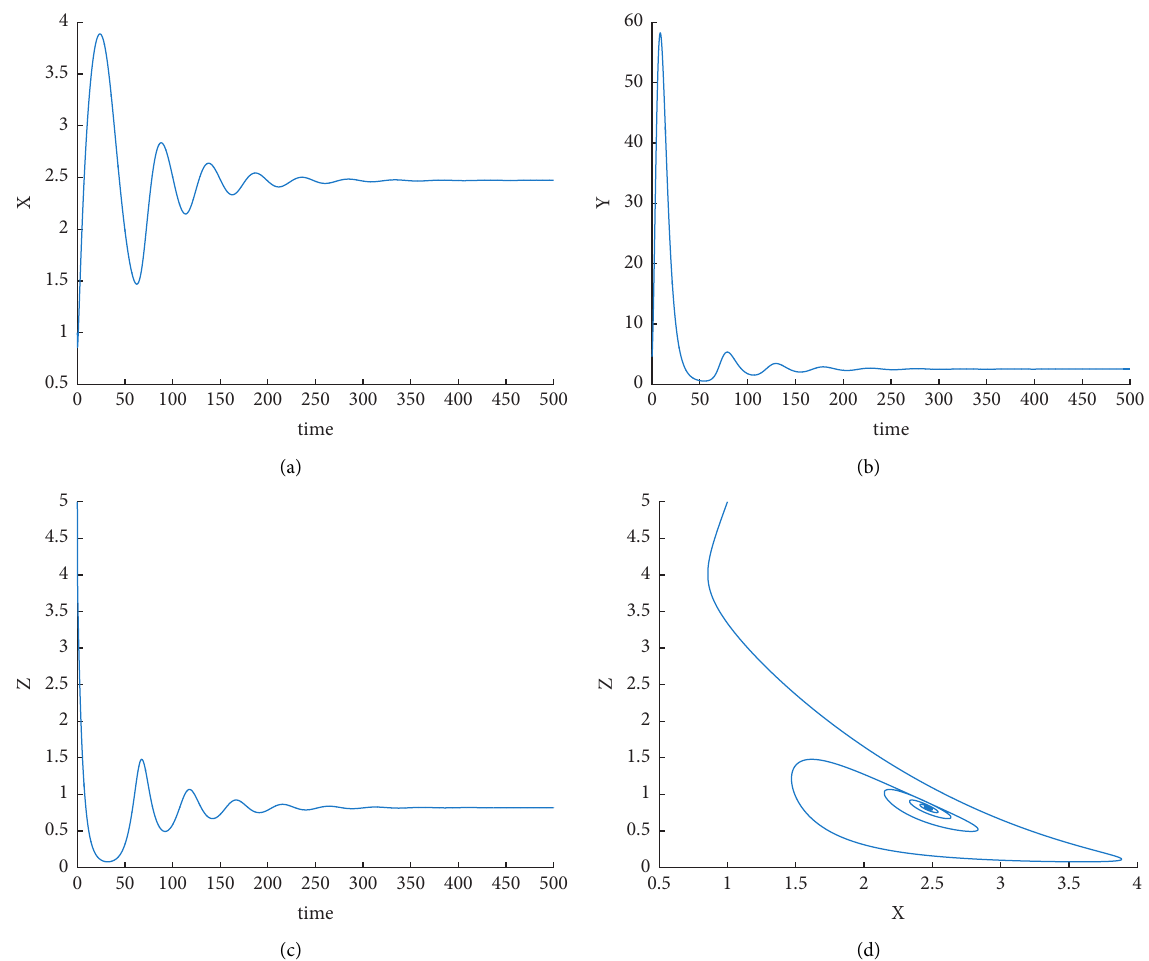
Figure 2: (a)–(d)) Dynamic of chemicals involved in bone formation process obtained through fractional model of bone remodeling process by